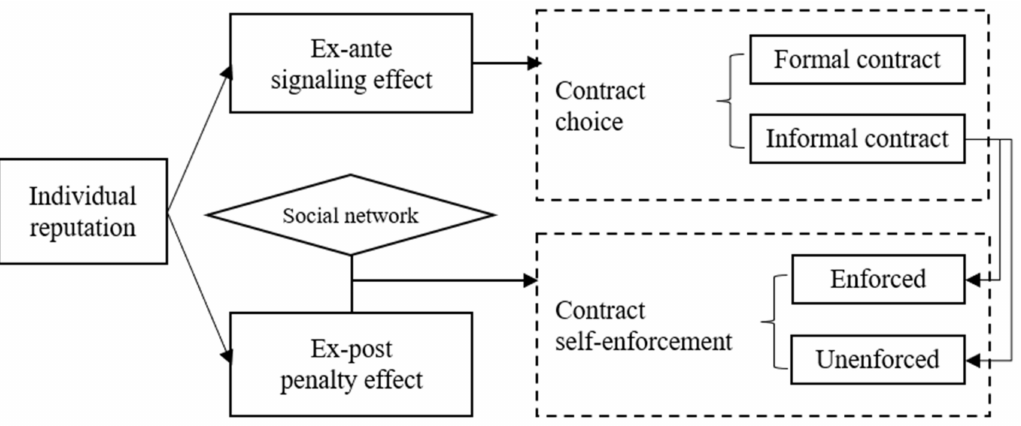
Figure 1. Theoretical framework of reputation effect on contract choice and